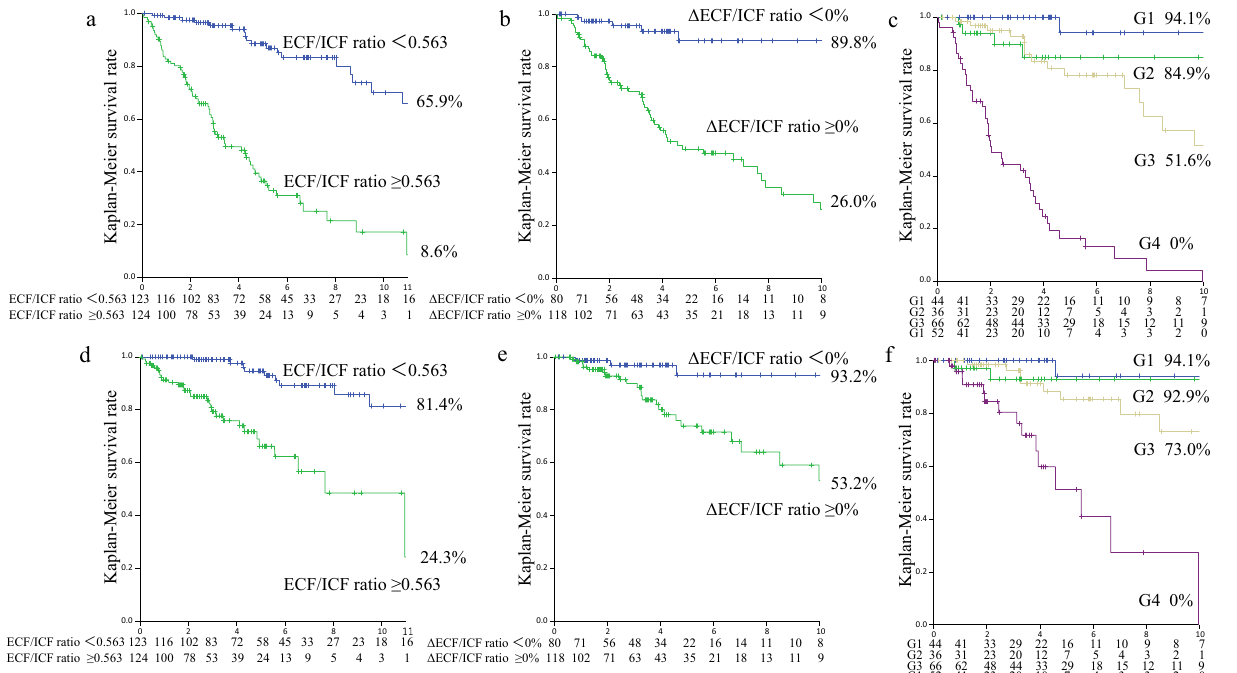
Figure 2. Kaplan–Meier survival rate for all-cause and cardiovascular mortality. All-cause mortality for the ECF/ICF ratio < 0.563 vs. the ECF/ICF ratio ≥ 0.563 ( a ), ∆ECF/ICF ratio < 0% vs. ∆ECF/ICF ratio ≥ 0% ( b ), and among the four groups divided by the baseline ECF/ICF ratio and ∆ECF/ICF ratio ( c ). Cardiovascular mortality for the ECF/ICF ratio < 0.563 vs. the ECF/ICF ratio ≥ 0.563 ( d ), ∆ECF/ICF ratio < 0% vs. ∆ECF/ICF ratio ≥ 0% ( e ), and among the four groups divided by the ECF/ICF ratio and the ∆ECF/ICF ratio ( f ). G1, ECF/ ICF ratio < 0.563 and ΔECF/ICF ratio < 0%; G2, ECF/ICF ratio ≥ 0.563 and ΔECF/ICF ratio < 0%; G3, ECF/ICF ratio < 0.563 and ΔECF/ICF ratio ≥ 0%; G4, ECF/ICF ≥ 0.563 and ΔECF/ICF ≥ 0%. ECF/ICF ratio, extracellular fluid/intracellular fluid ratio; ΔECF/ICF ratio, annual change in ECF/ICF ratio.